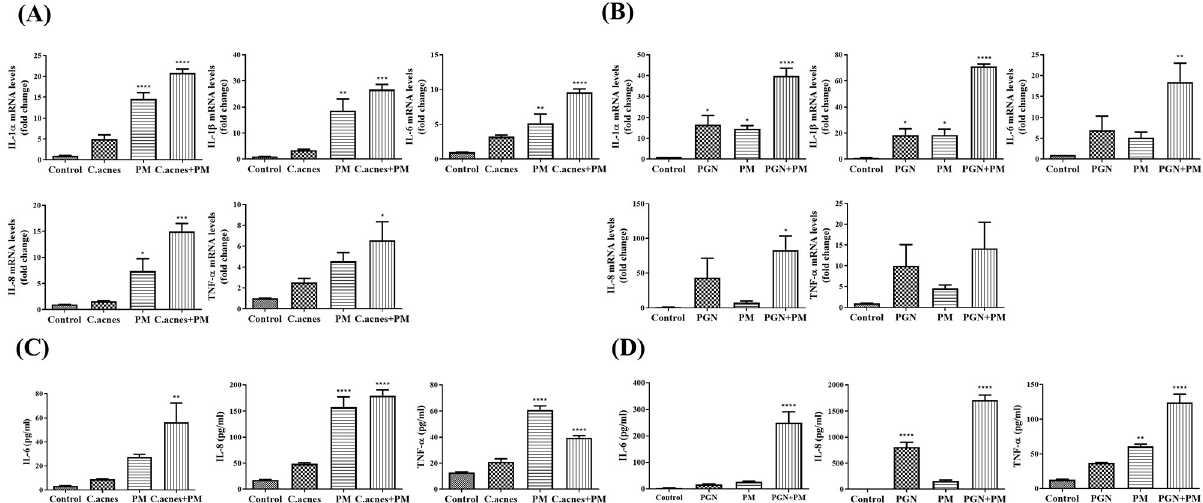
Fig 2. PM increases the expression of proinflammatory cytokines in C . acnes (500 MOI), or PGN (10 μ g/mL) treated HEKn cells. HEKn cells are co-treated with PM (10 μ g/cm 2 ) and heat-killed C . acnes (500 MOI) or PGN (10 μ g/mL) for 24 h. qRT-PCR results demonstrate that PM increases the mRNA expression of IL-1 α , IL-1 β , IL-6, IL-8, and TNF- α in (A) C . acnes and (B) PGN-treated cells. The relative mRNA levels are presented as fold change compared with untreated cells (0 μ g/cm 2 ). ELISA results show that PM also increases the protein expression of proinflammatory cytokines in (C) C . acnes or (D) PGN-treated cells. Data are shown as mean + SEM. Statistical significance was determined by repeated measures ANOVA, post hoc Bonferroni correction, comparing to control ( � p < 0.05, �� p < 0.01, ��� p < 0.001, ���� p < 0.0001).